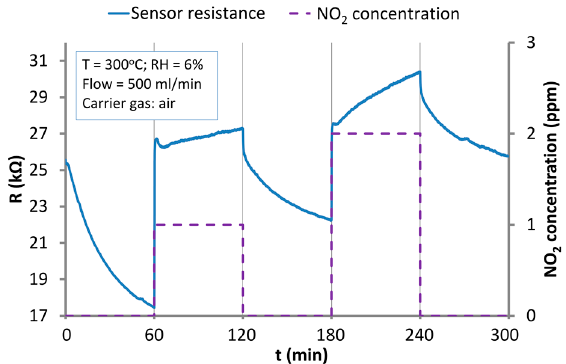
Figure 7. The response of the sensor based on ZnO nanostructures to the action of NO 2 in the atmosphere of synthetic air at 300 °C.